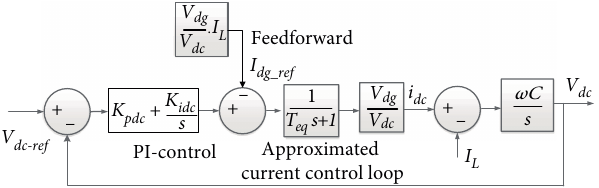
Figure 16: The control structure of the DC voltage control of the DC link in the VSCs.